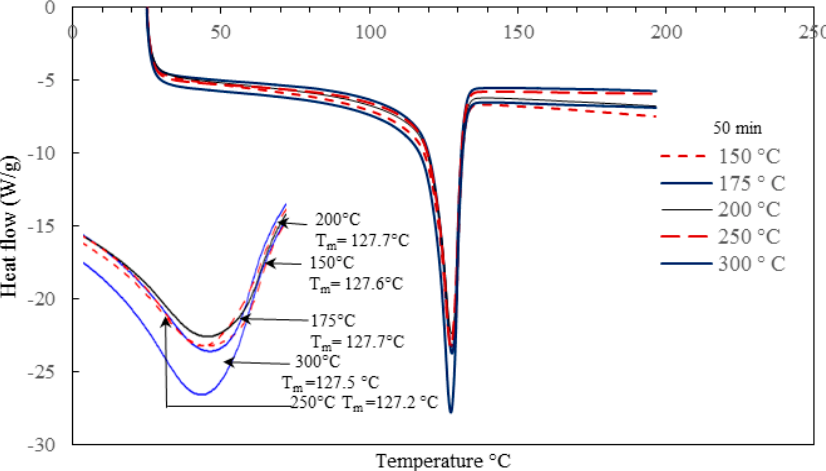
Figure 18. Effect of barrel temperature on the melting temperature of the injection molded HDPE/TiO 2 nanocomposites.